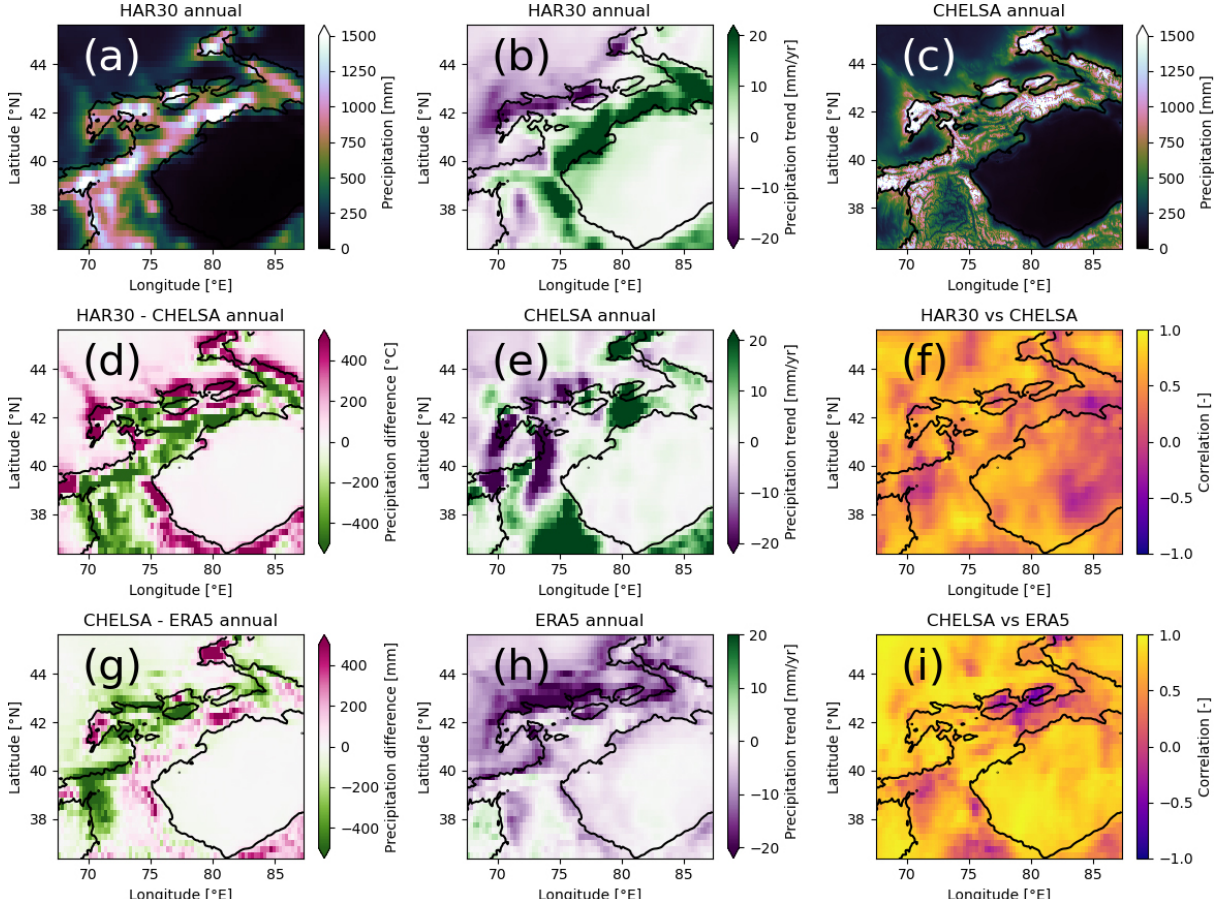
Figure 3. Sums of mean annual precipitation for (a) HAR30 and (c) CHELSA. Trends for (b) HAR30, (e) CHELSA, and (h) ERA5. Differ- ences between (d) HAR30 and CHELSA and (g) CHELSA and ERA5 and the correlation between (f) HAR30 and CHELSA and (i) CHELSA and ERA5. CHELSA and ERA5 were spatially resampled bilinearly to the resolution of HAR30 for the differences and correlation. Black outlines correspond to 2000ma.s.l. altitude. The same figure for temperature is provided in the Appendix (Fig.